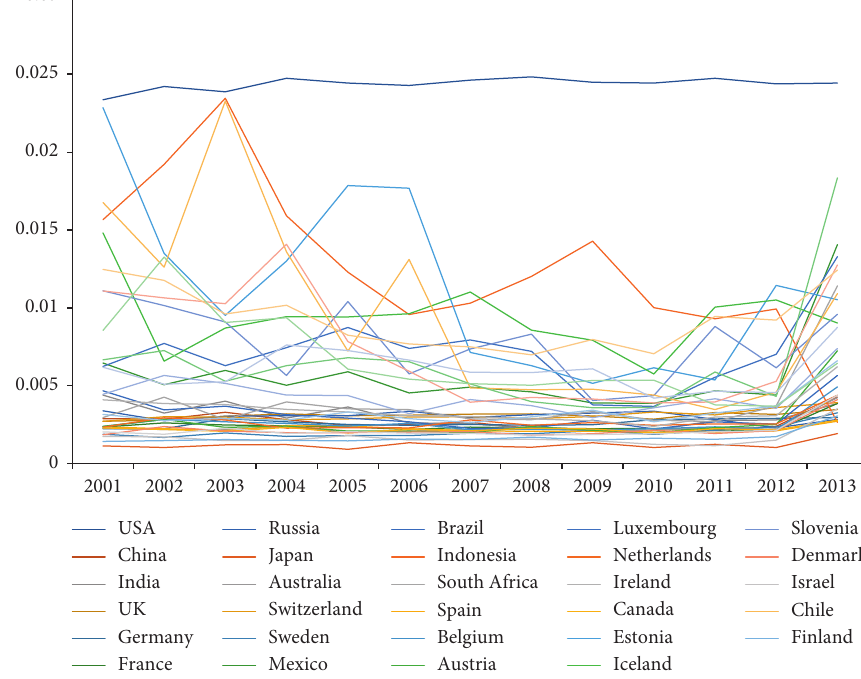
Figure 7: Evolutions of clustering coefficient of the chosen countries under directed weighted topology from 2001 to